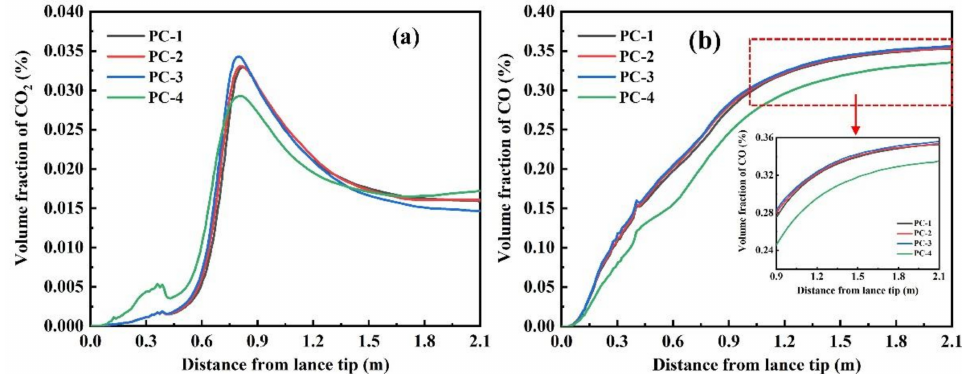
Figure 13. Variation trends of CO 2 ( a ) and CO ( b ) concentrations along the tip of the coal lance with different ratios of